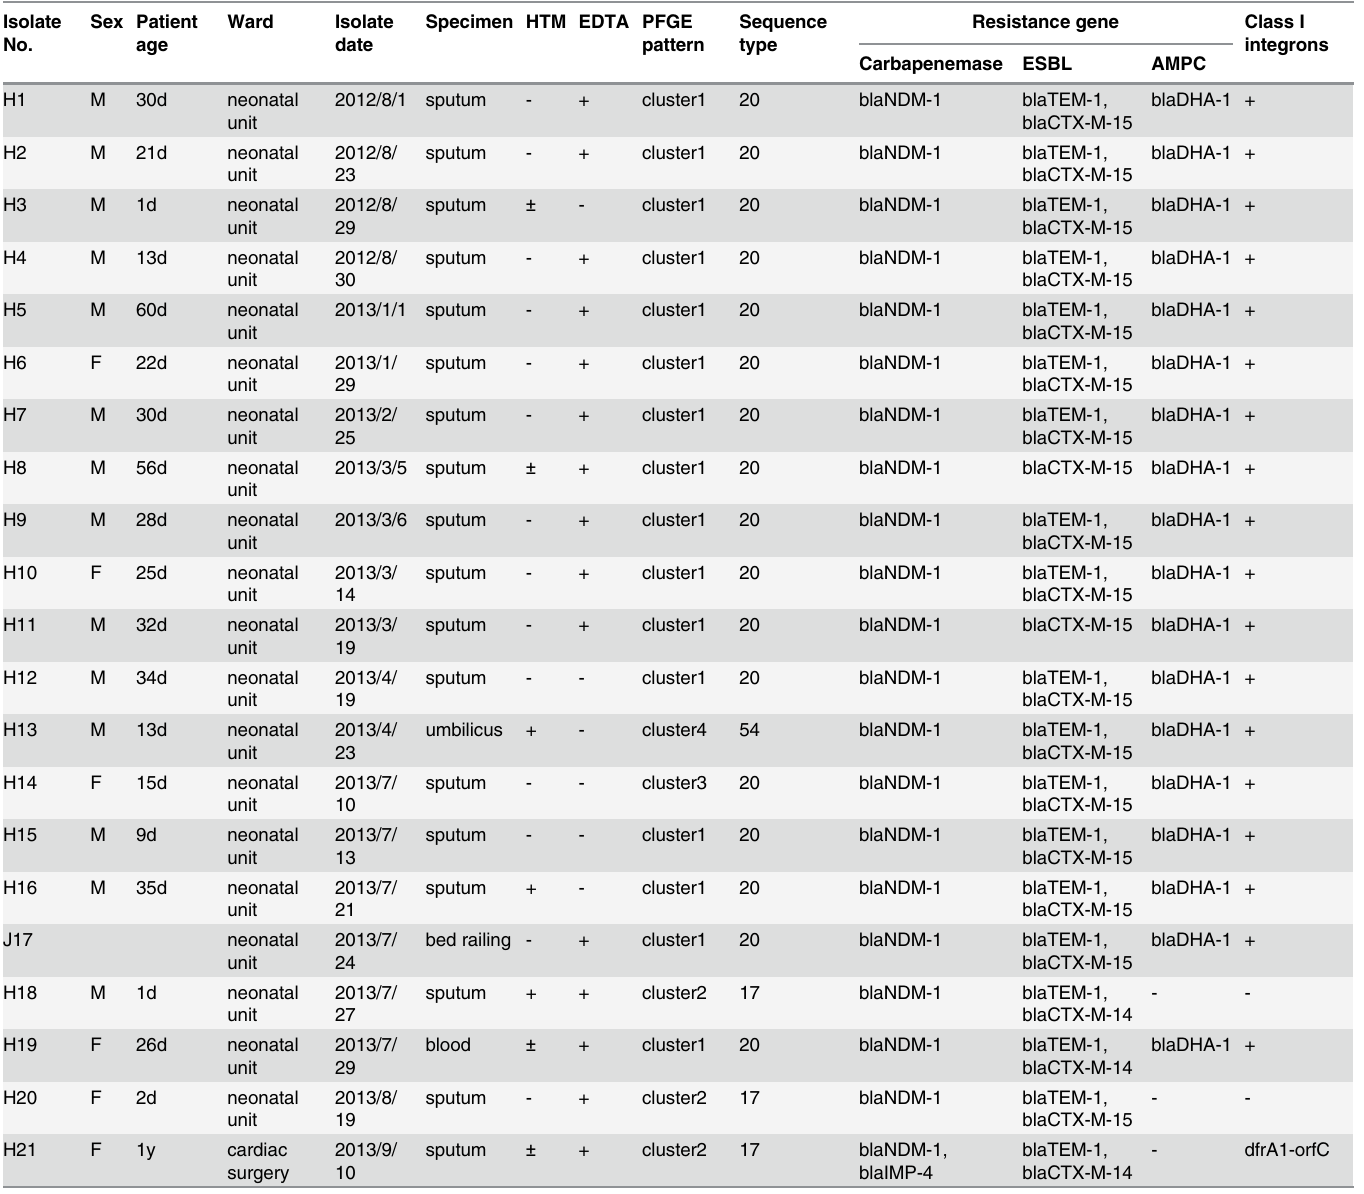
Table 1. Characteristics of 21 K . pneumoniae isolates with NDM-1. Isolate